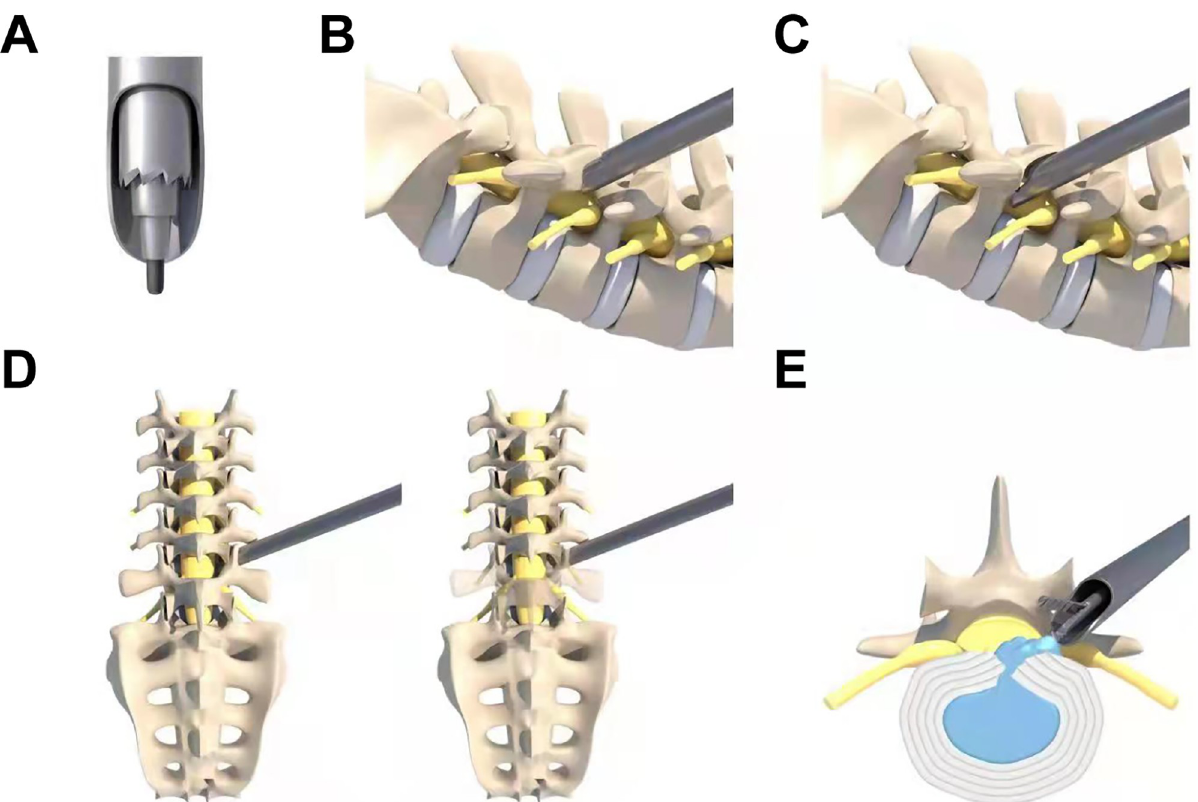
Fig 1. The schematic illustration of foraminoplasty with a single large trephine. (A) Position diagram of the guide rod, the dilating cannula, the trephine and the tongue-shaped protective sheath. (B) Lateral position of the dilating cannula. (C) One-step foraminoplasty via a large trephine. (D) Anteroposterior diagram of the dilating cannula and foraminoplasty via a large trephine. (E) Removal of the nucleus